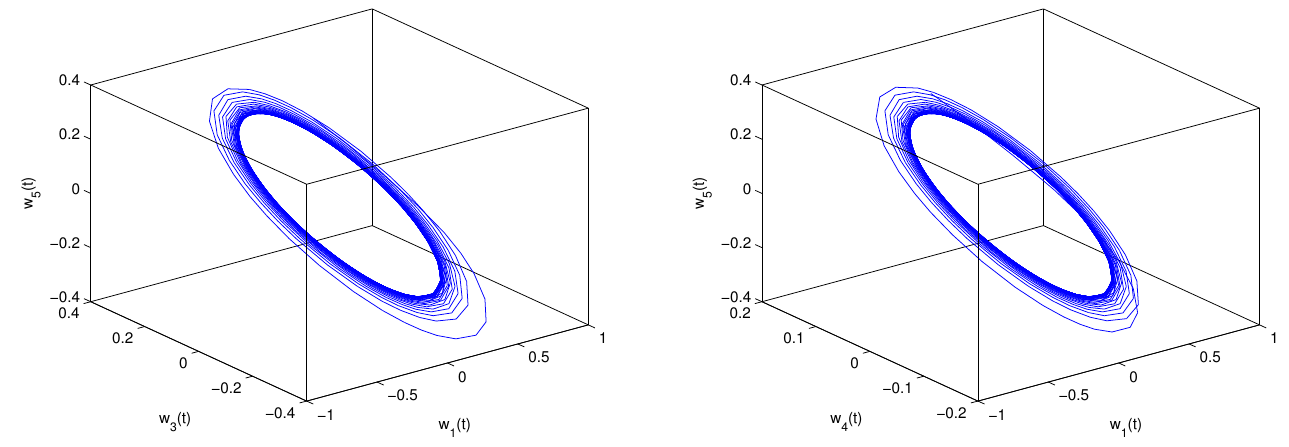
Figure 16. Matlab simulation outcomes for system (73) when ϑ = 0.33 > ϑ ∗ = 0.32. System (73)